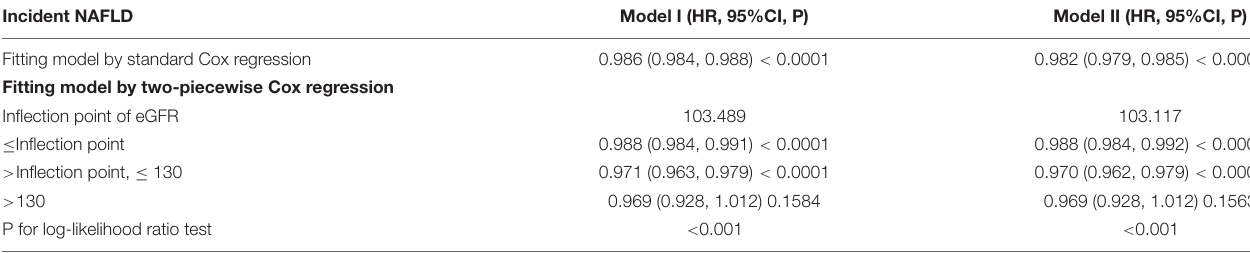
TABLE 6 | The result of the two-piecewise Cox regression model.